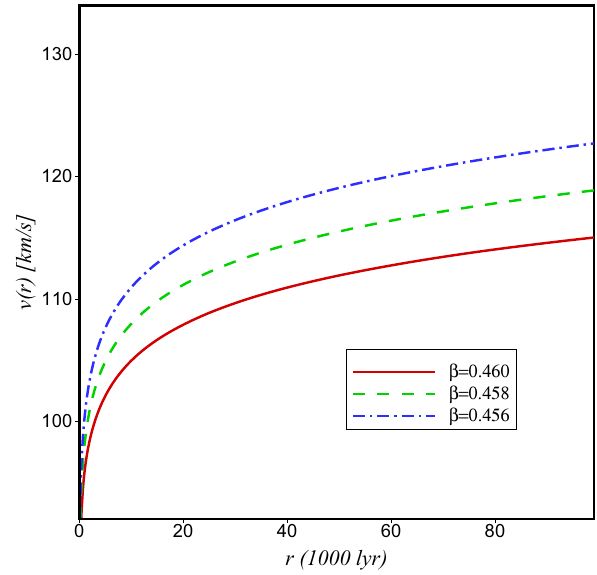
Fig. 1 The speed of a test particle around a spiral galaxy in terms of the distance for β = 0 . 40 and different values of galaxy mass M i = γ × 10 9 M (cid:12) i